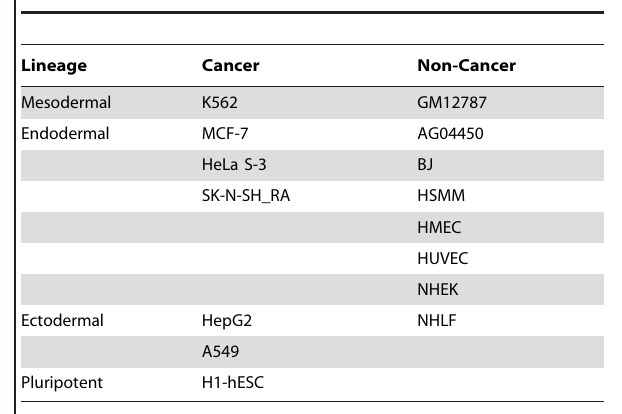
Table 1. ENCODE cell types analyzed by lineage and cancer